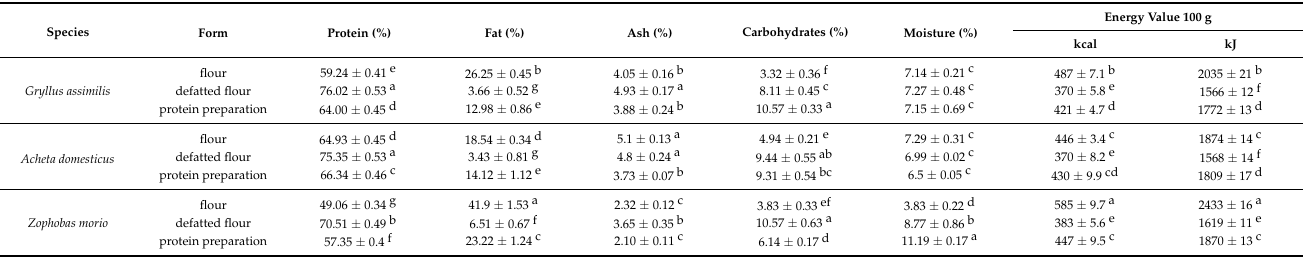
Table 1. Nutritive value of studied insects form. Different letters in the same column indicate a significant difference ( p < 0.05).